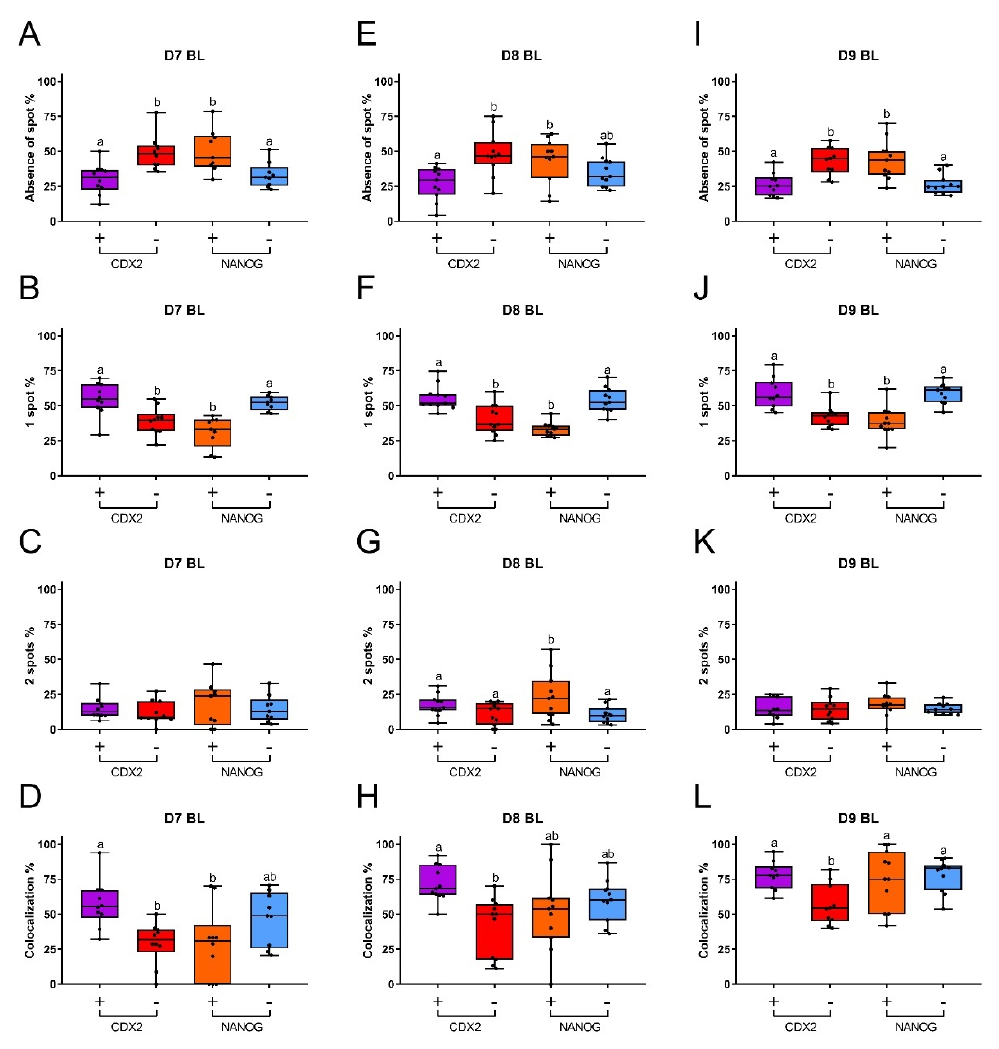
Figure 5. Percentages of nuclei with di ff erent numbers of XIST spots in CDX2 and NANOG positive or negative cells, and percentages of colocalization of XIST and H3K27me3 from day 7 to day 9 female blastocysts. Absence of an XIST spot ( A ), one XIST spot ( B ), two XIST spots ( C ), and colocalization of XIST and H3K27me3 ( D ) in day 7 (D7) blastocysts; absence of an XIST spot ( E ), one XIST spot ( F ), two XIST spots ( G ), and colocalization of XIST and H3K27me3 ( H ) in day 8 (D8) blastocysts; absence of an XIST spot ( I ), one XIST spot ( J ), two XIST spots ( K ), and colocalization of XIST and H3K27me3 ( L ) in day 9 (D9) blastocysts. Presence (purple box) and absence (red box) of CDX2 are indicated by + and -, respectively. Presence (orange box) and absence (blue box) of NANOG are indicated by + and -, respectively. Significant di ff erences between boxes are indicated by di ff erent letters ( p < 0.05). BL = blastocyst.